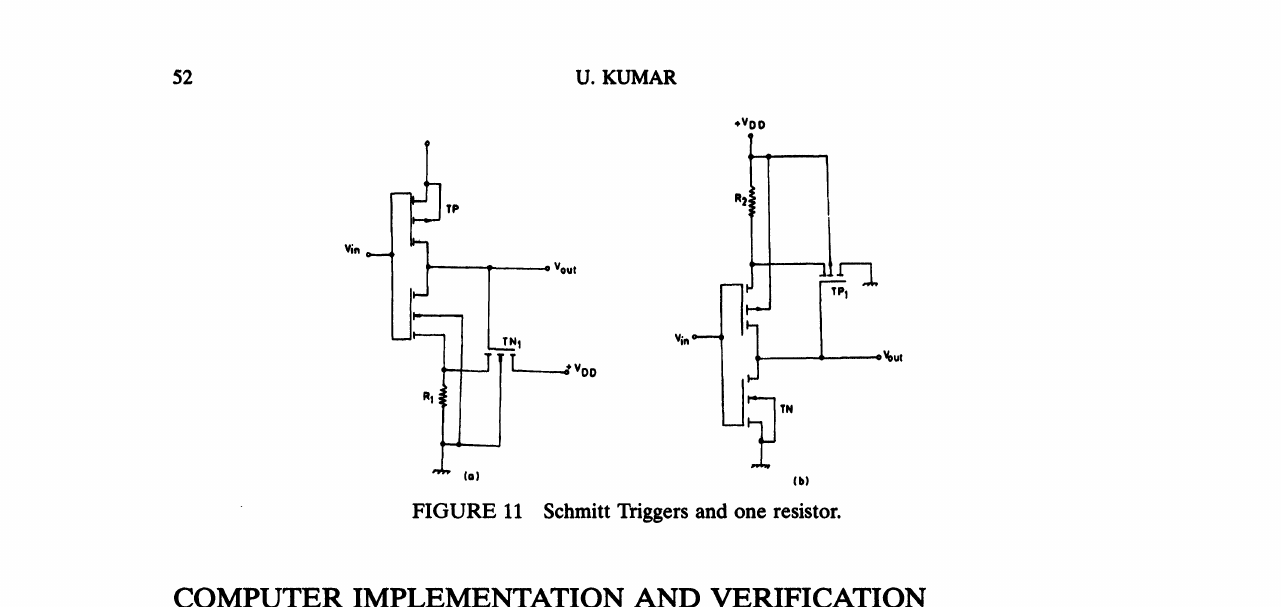
FIGURE 11 Schmitt Triggers and one resistor.